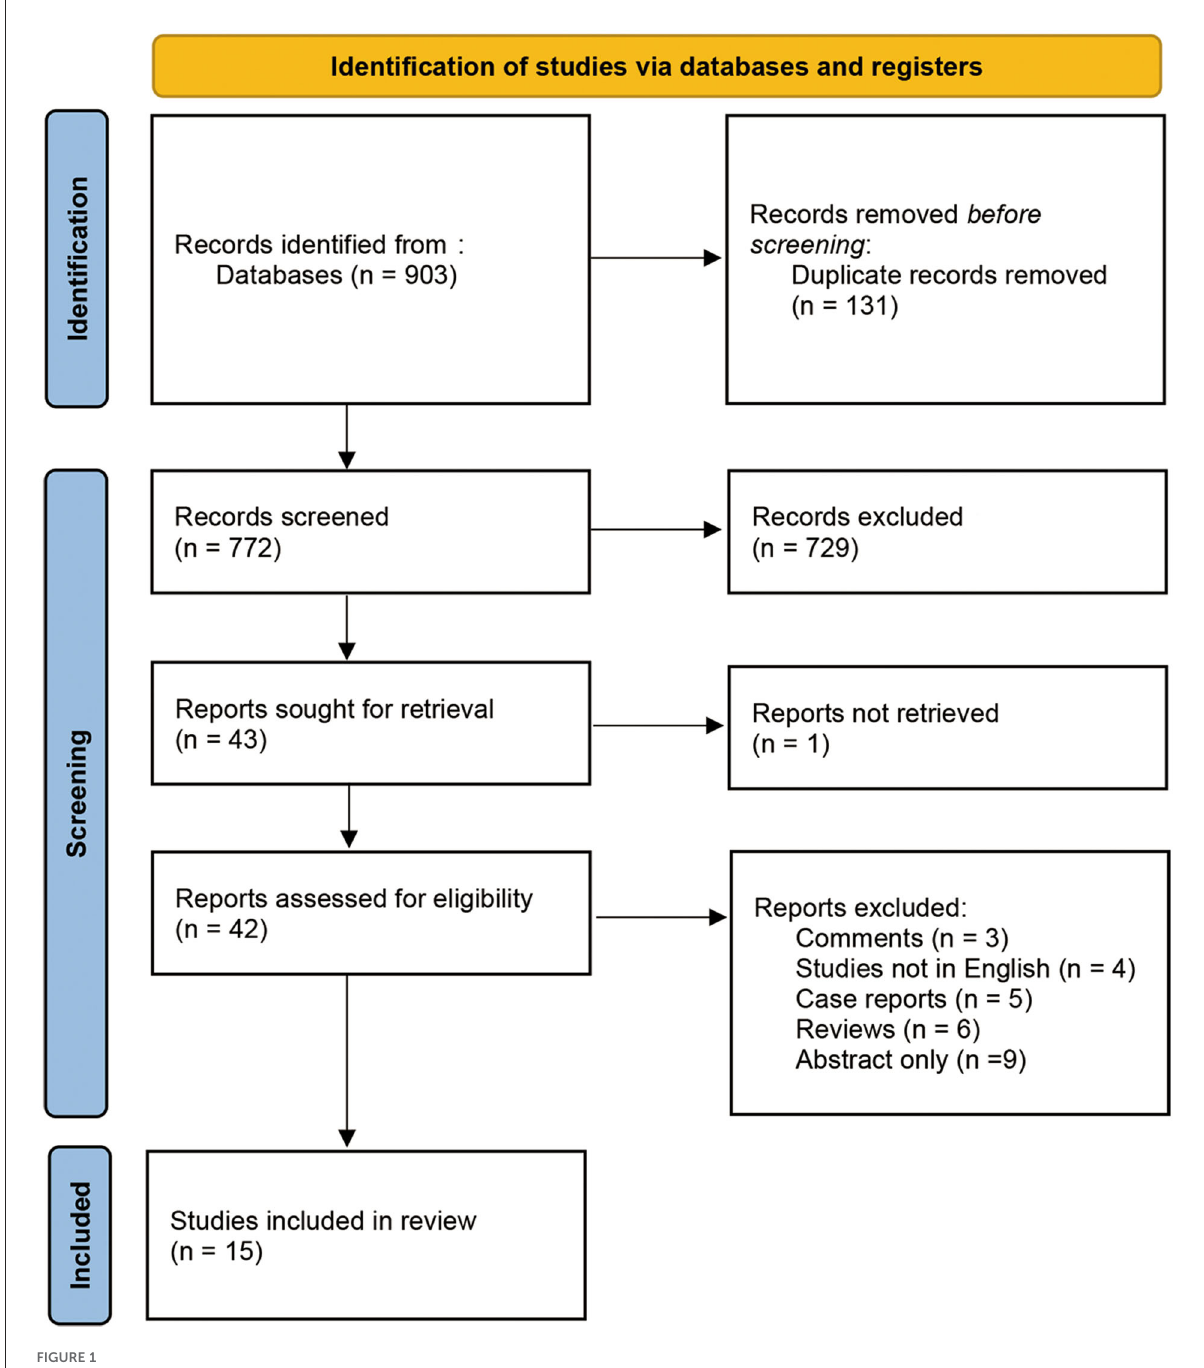
FIGURE1 PRISMA meta-analysis search strategy flow